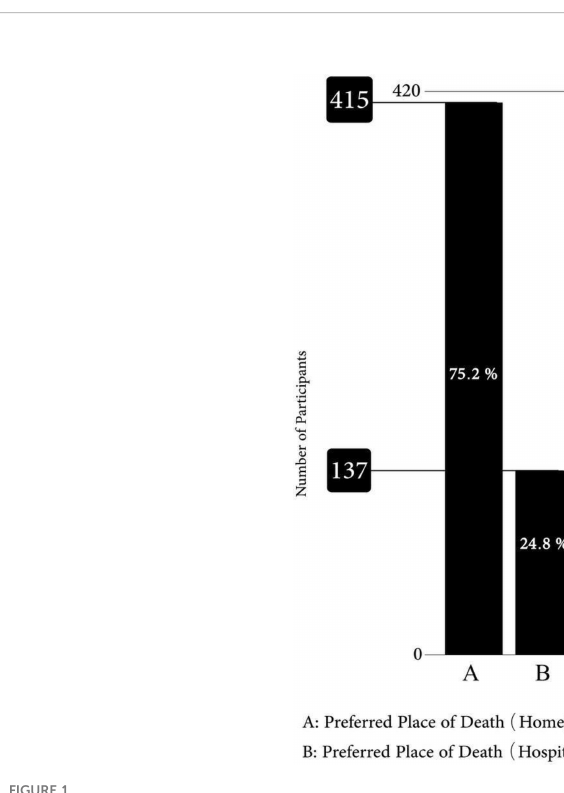
FIGURE 1 Preferred place of care and death of patients with cancer